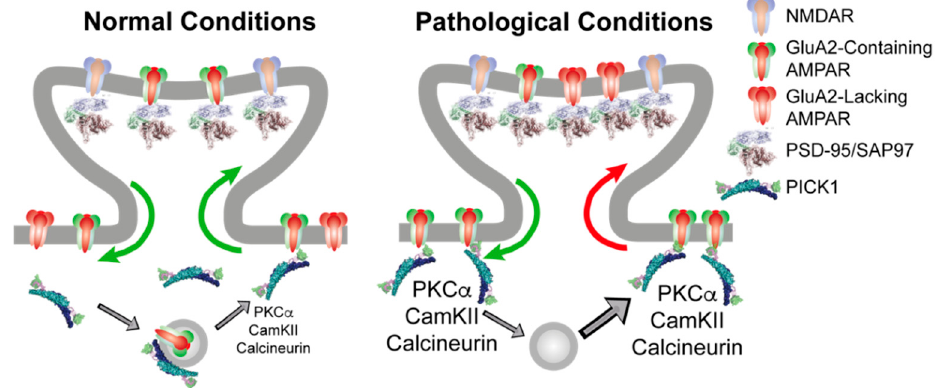
Figure 1. PICK1 serves an indirect role in regulating the synaptic AMPAR level and composition. ( Left ) Under basal conditions, PICK1 can anchor GluA2 containing AMPARs at extrasynaptic sites, as well as in intracellular vesicle stores, either derived from the endoplasmatic reticulum or belonging to recycling compartments. Synaptic and extrasynaptic GluA2-containing receptors are in continuous exchange, as indicated by green arrows, depending on the phosphorylation pattern, which, in turn, is subject to regulation by PICK1. ( Right ) Following repeated high-intensity stimulation giving rise to NMDAR activation and Ca 2+ influx, there is an increase in the total AMPAR surface expression from PICK1 containing intracellular compartments. This increases the kinase activity to modify AMPAR C-terminal phosphorylation patterns in a PICK1-dependent manner, leading to increased PICK1-dependent stabilization of GluA2 containing receptors at extrasynaptic sites (green arrow). This extrasynaptic trapping of GluA2-containing AMPARs allows GluA2-lacking CP-AMPARs to access the synapse, giving rise to increased Ca 2+ influx and an inflexible synaptic strengthening.